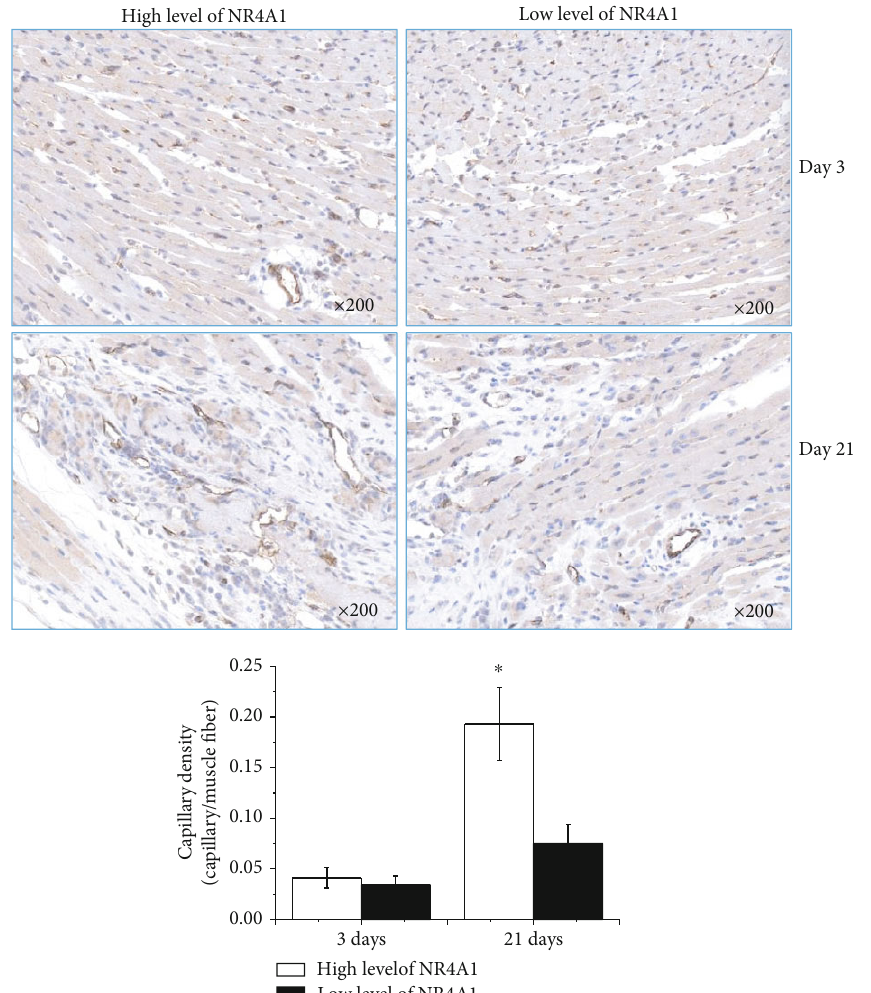
Figure 5: IHC analysis for the expression of CD31 in AMI mouse hearts of di ff erent groups (magni fi cation × 200). CD31-positive endothelial cells in C57BL/6 CX3CR1-/- AMI mice following MSC transplantation were compared on days 3 and 21. ∗ p < 0 : 05 vs. the corresponding low- NR4A1 expression level group. Abbreviations: NR4A1: nuclear receptor subfamily 4 group A member